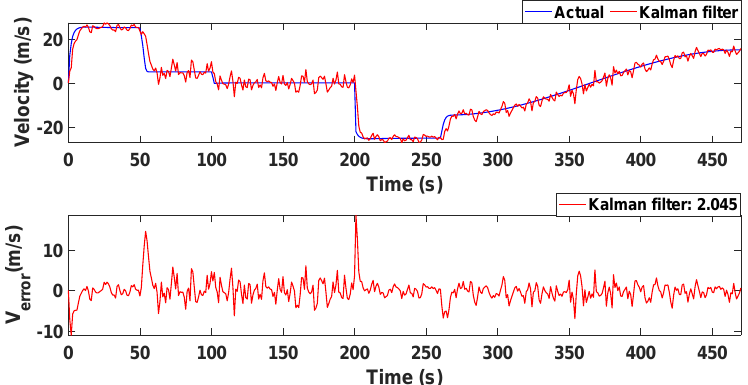
Figure 11. Simulation of the Kalman filter for velocity and position estimation.